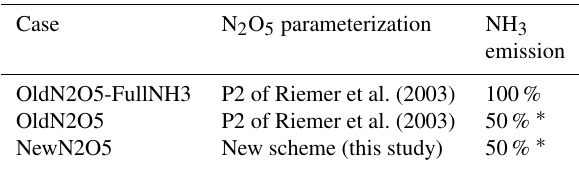
Table 2. Sensitivity simulation